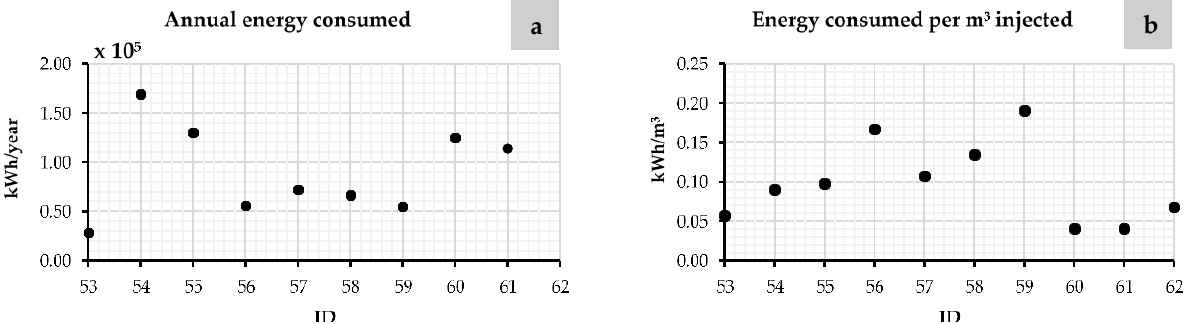
Figure 8. Efficiency indicators in networks with PATs installed. Annual Energy consumed ( a ); Energy consumed per m 3 injected ( b ).